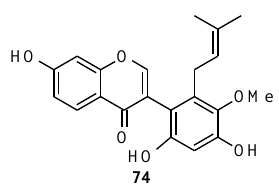
Figure 6. Structure of kwakhurin.